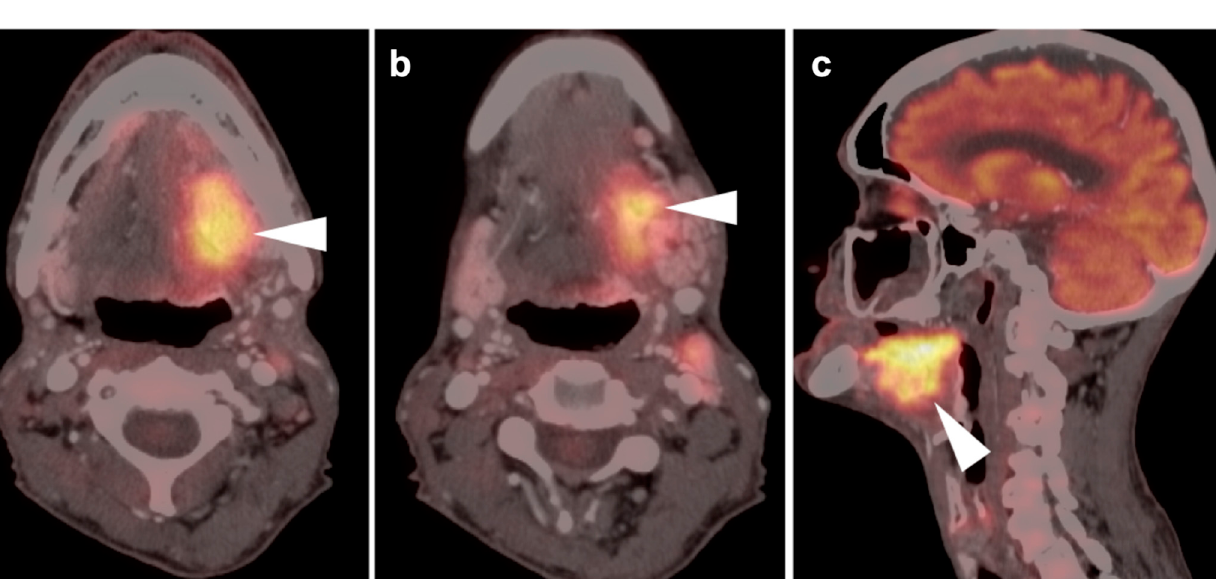
Figure 12. Squamous cell carcinoma of the oral cavity with bony involvement. ( a ) Soft tissue win ‐ dow FDG PET ‐ CT demonstrates a hypermetabolic lesion of the left mandibular alveolar mucosa (white arrow). ( b ) Bone windows demonstrate destruction of the adjacent cortical bone at the mental foramen, consistent with bony involvement (white arrowhead). 2. Oropharyngeal squamous cell carcinoma